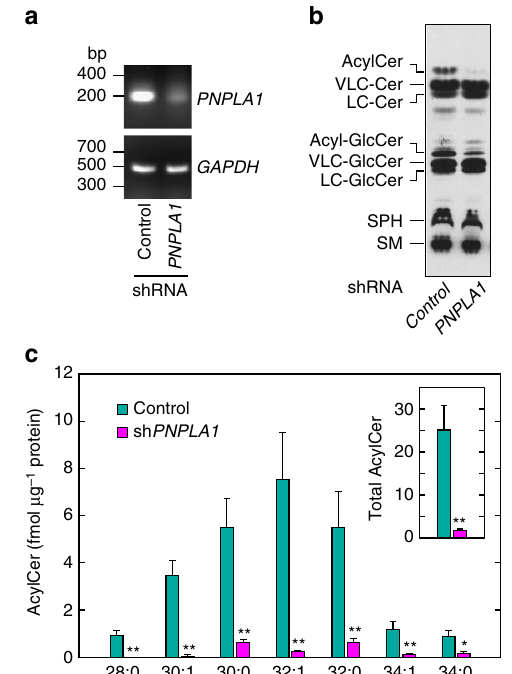
Figure 2 | Knockdown of PNPLA1 causes impairment of acylceramide production. Keratinocytes were infected with lentivirus harbouring control shRNA or sh PNPLA1 and were differentiated for 7 days. ( a ) Total RNAs prepared from differentiated keratinocytes were subjected to RT-PCR using primers specific for PNPLA1 and GAPDH . Uncropped scanned photographs of the electrocataphoresis gels are provided as Supplementary Fig. 2. ( b ) Cells were labelled with [ 3 H]sphingosine for 6h at 37 (cid:2) C in the presence of 10 m M linoleic acid. Lipids were extracted, separated by normal- phase TLC and detected by autoradiography. AcylCer, acylceramide; Cer, ceramide; Acyl-GlcCer, acyl-glucosylceramide; GlcCer, glucosylceramide; SPH, sphingosine; SM, sphingomyelin. Two independent experiments gave similar results, and a representative result is shown. ( c ) Lipids were extracted and subjected to LC-MS/MS analysis. Acylceramides were detected in the MRM mode and quantified using MassLynx software. The graph depicts the amount of each acylceramide species with the indicated FA chain-length. The inset represents the total acylceramide levels. Values represent the means ± s.d.s of three independent experiments. Statistically significant differences compared to control cells are indicated (two-tailed Student’s t -test; * P o 0.05; ** P o